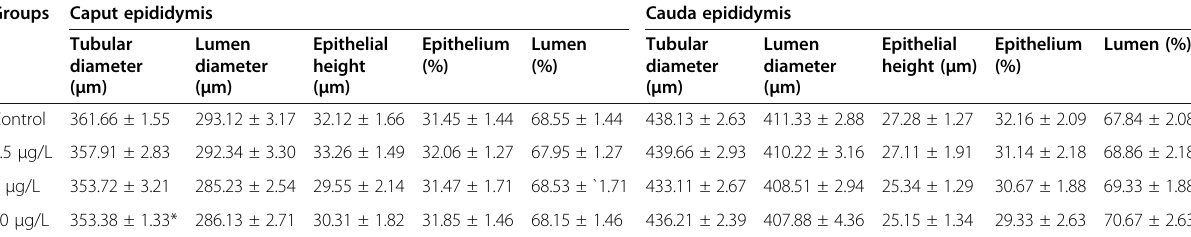
Table 6 Effect of chronic exposure of different concentrations of BPS (0.5 μ g/L, 5 μ g/L, and 50 μ g/L) on planimetry of caput and cauda epididymis in